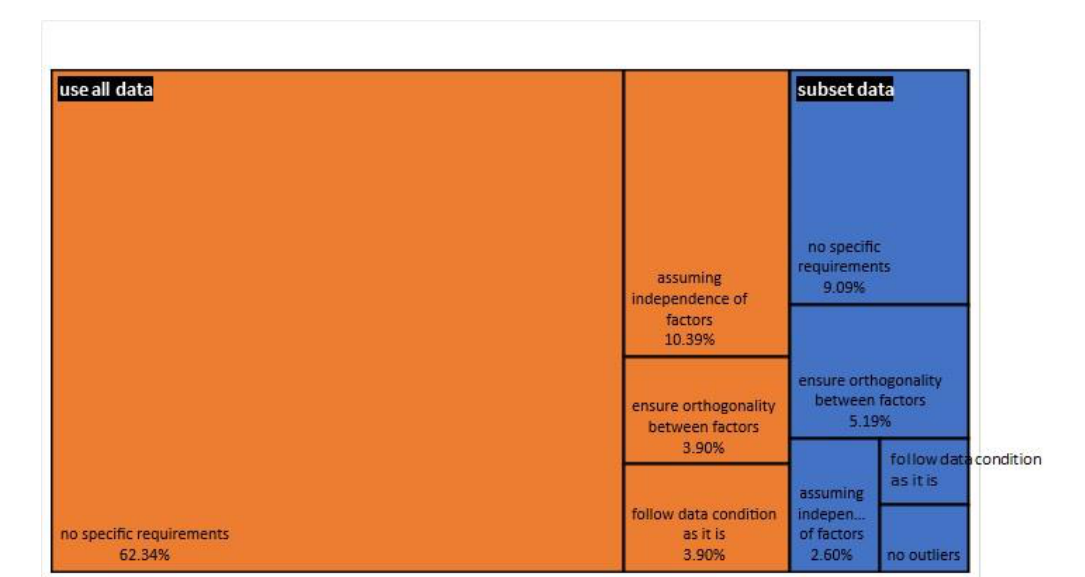
Figure 9. Data conditions based on the number of data involved in RSM-OD. Table 5. Required data condition for